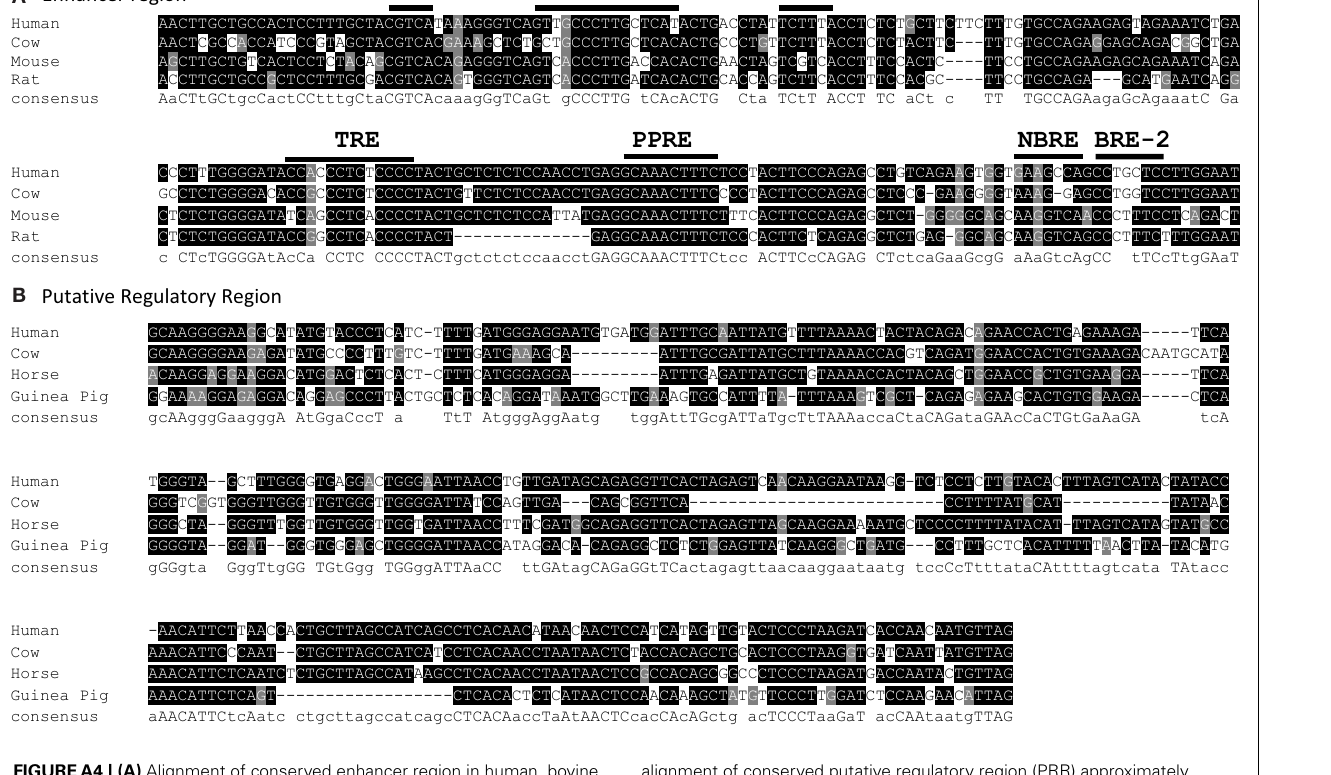
FIGUREA4 | (A) Alignment of conserved enhancer region in human, bovine, rat, and mouse, approximately − 3800bp of human UCP1. Positions of known transcription factor binding sites taken from Jastroch et al. (2008) (B) Partial